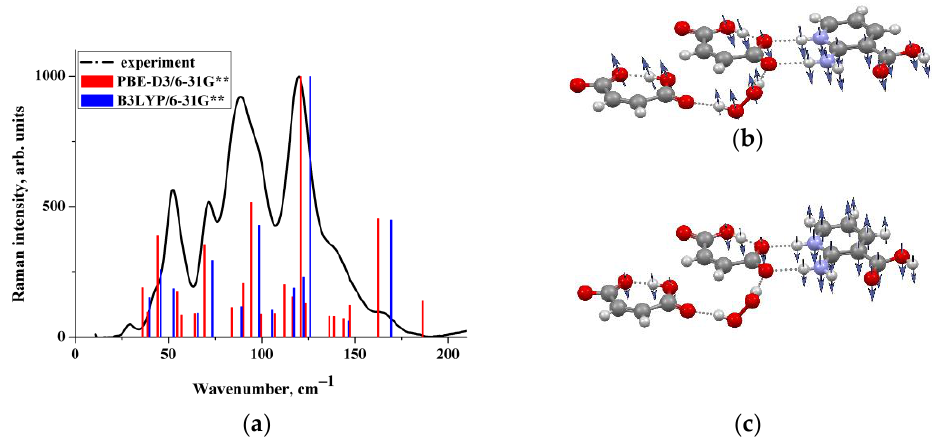
Figure 5. The experimental (black line) and calculated (PBE-D3 — red sticks and B3LYP — blue sticks) low-frequency Raman spectra of the [2AmNic+Mle+H 2 O 2 ] crystal ( a ). The theoretical values of wavenumbers are scaled by 0.9. The height of the bars is proportional to the relative Raman intensity of the corresponding transition. The schematic representation of the atom displacements of the two Raman intense vibrations (PBE-D3/6-31G**) at 44 cm −1 ( b ) and 94 cm − 1 ( c ).